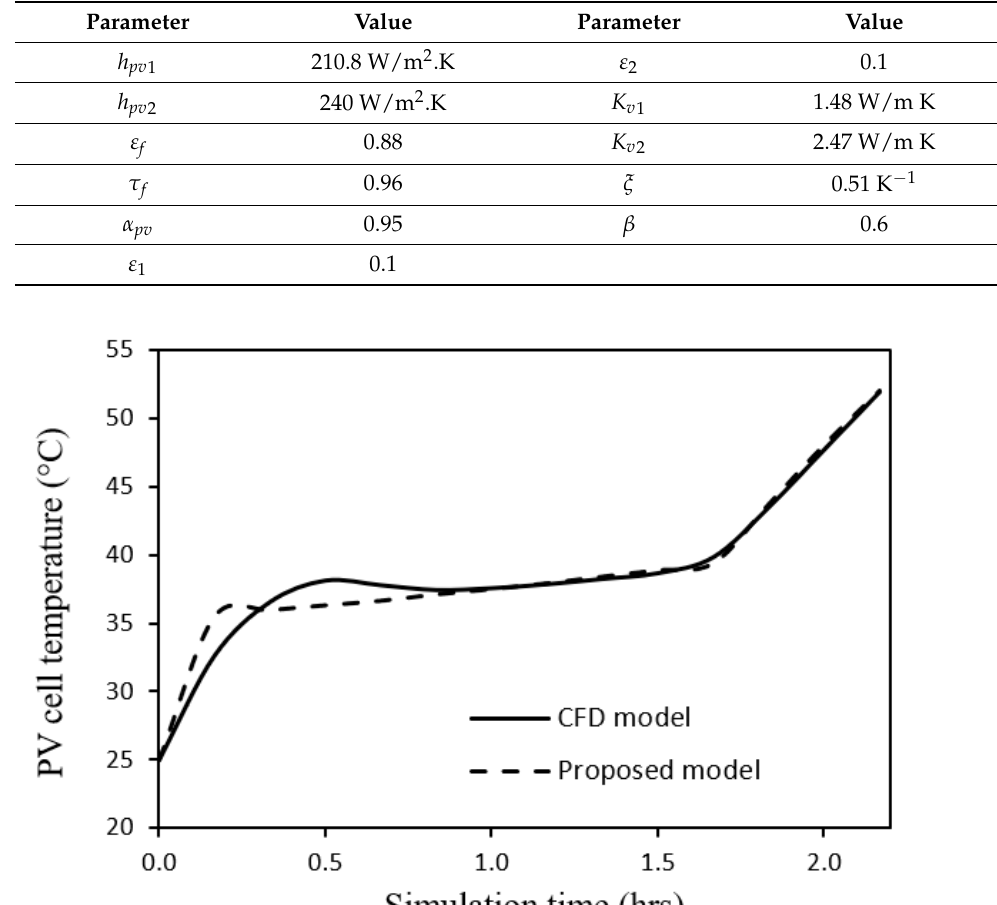
Table 2. The main design parameters of the proposed model.